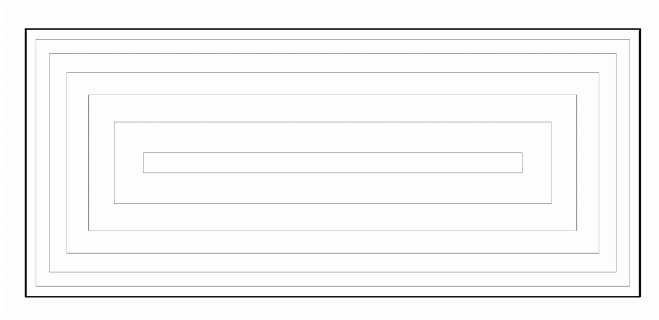
Figure 4. Path with variable distances between lines